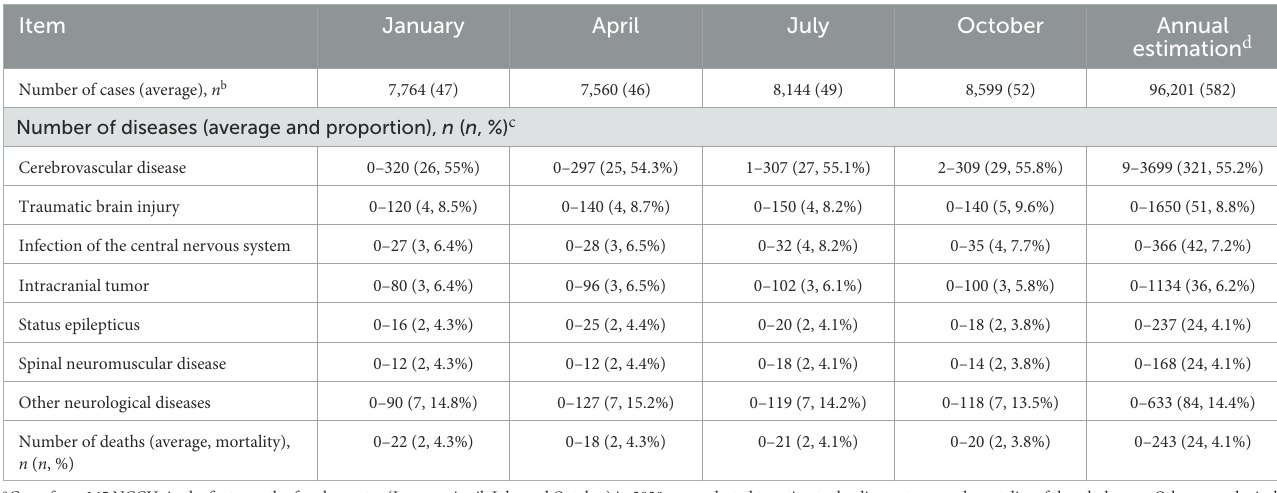
TABLE 1 Disease proportion and mortality of 165 NCCU patients in 2020 a